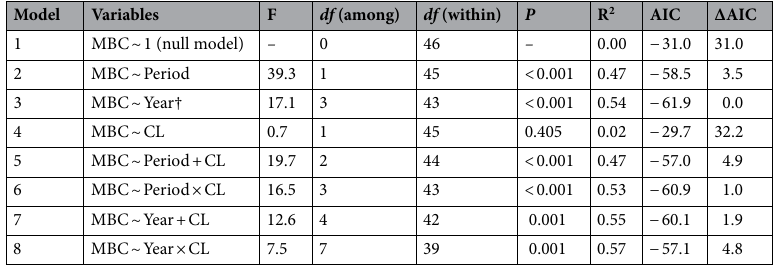
Table 2. Linear model selection results based on minimization of Akaike’s information criterion (AIC) for southern right whale maternal body condition (MBC). CL calf relative length (% maternal length). † The most parsimonious model (Model 3).